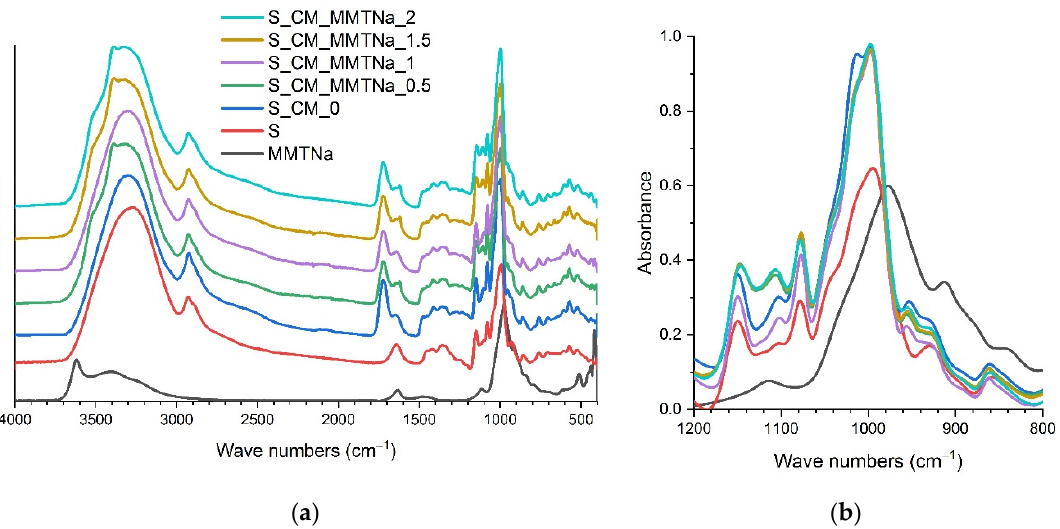
Figure 4. FTIR–ATR spectra of sodium montmorillonite, starch and films with various nanofiller contents: ( a ) full spectrum, ( b ) range 1200–800 cm -1 .